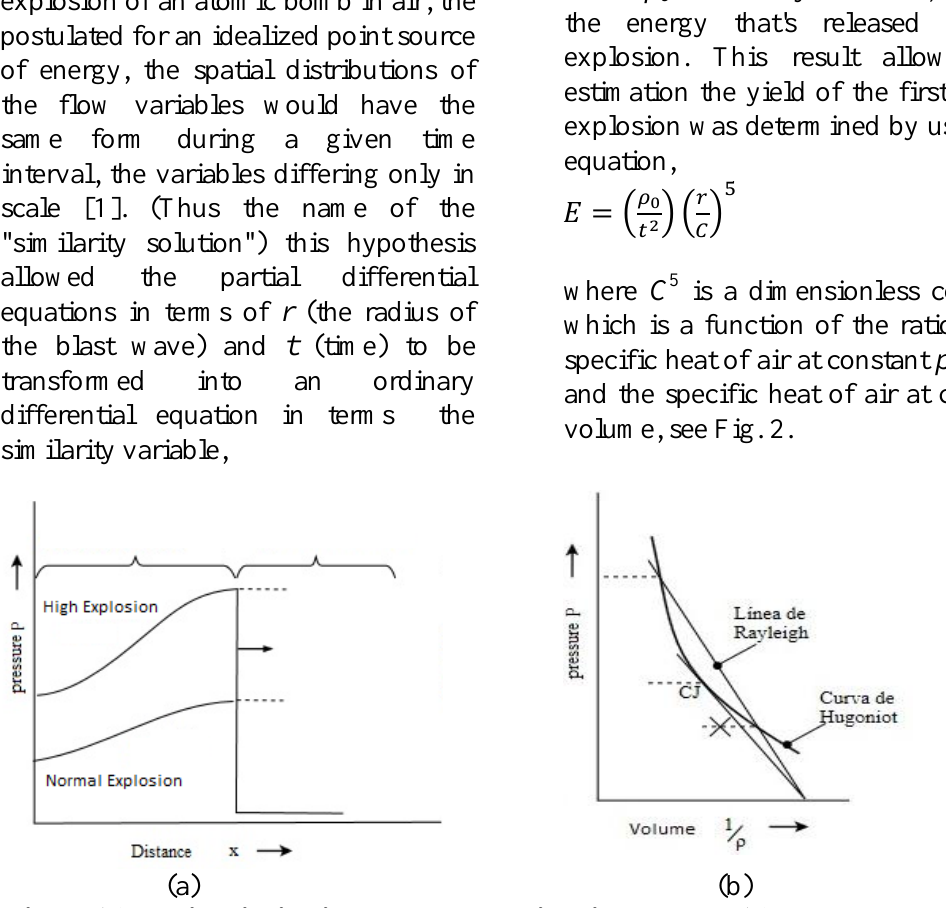
Fig. 2: (a) Spatial distributions of pressure with distance, and (b) constant pressure with volume